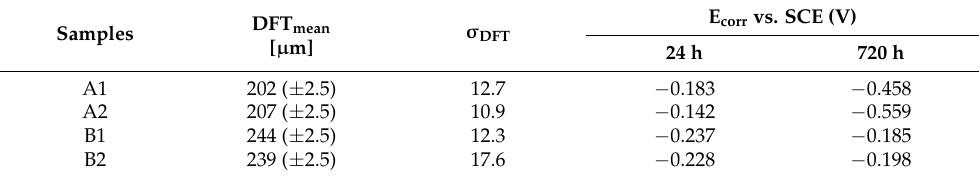
Table 6. The open circuit potential results after stabilization in 3% NaCl